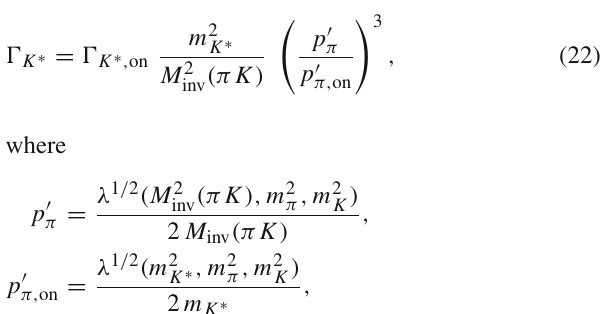
(with cos θ = 1) √ dcos θ d M inv ( K 0 π + K − ) s = 2850 MeV